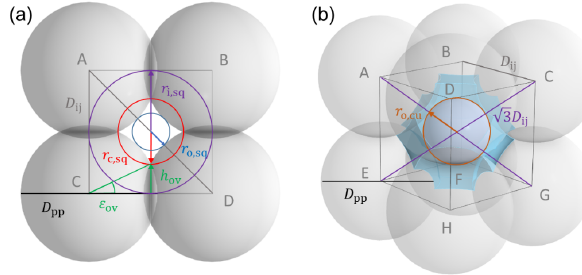
Figure A2. Dimensions of the different pore types formed in the case of a cubic packing arrangement of overlapping spheres with diameter D pp . (a) Top view of the four-membered ring pore that forms between the four spheres with centres at the corners of the square ABCD. (b) The inner cavity formed within the cubic cell between eight neighbouring spheres of two lattice layers has the form of a concave cube (blue